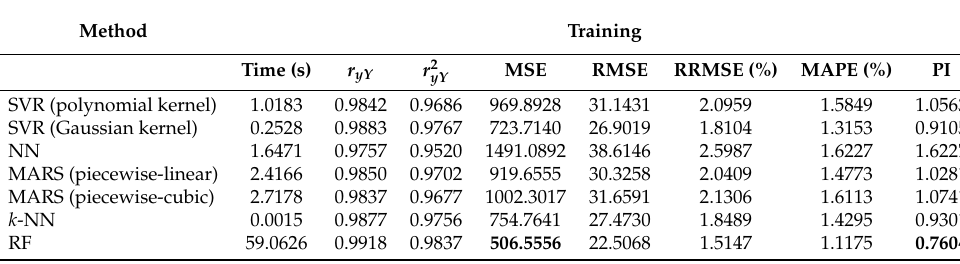
Table 14. Performance of the machine learning in temperature prediction based on dynamic